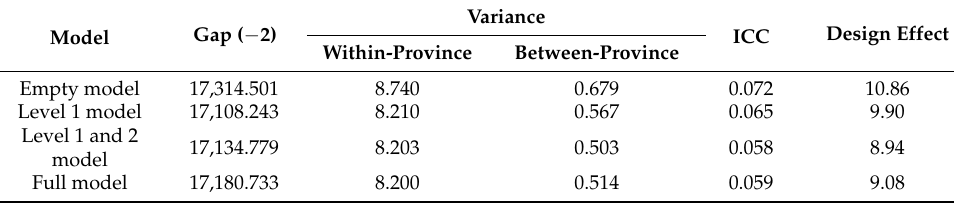
Table 2. The gap value, variance, ICC, and design effect value of